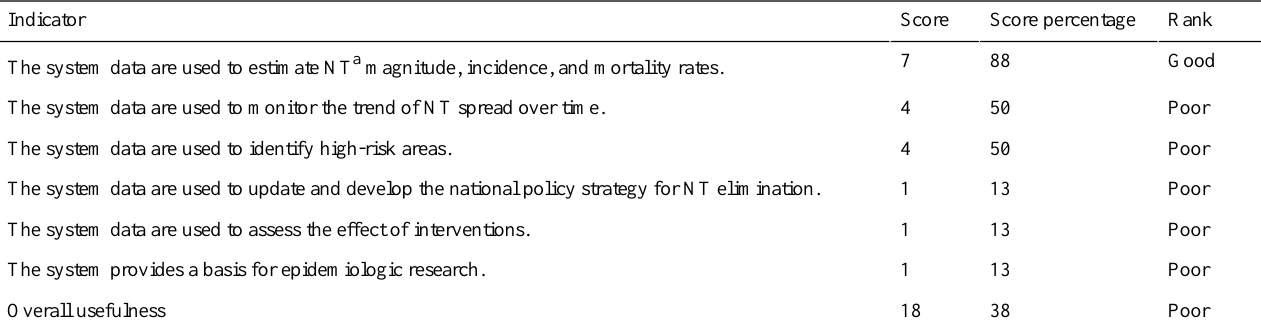
Table 1. The score, score percentage, and rank of usefulness indicators of the Neonatal Tetanus Surveillance System in Sana’a, 2018 (n=8).